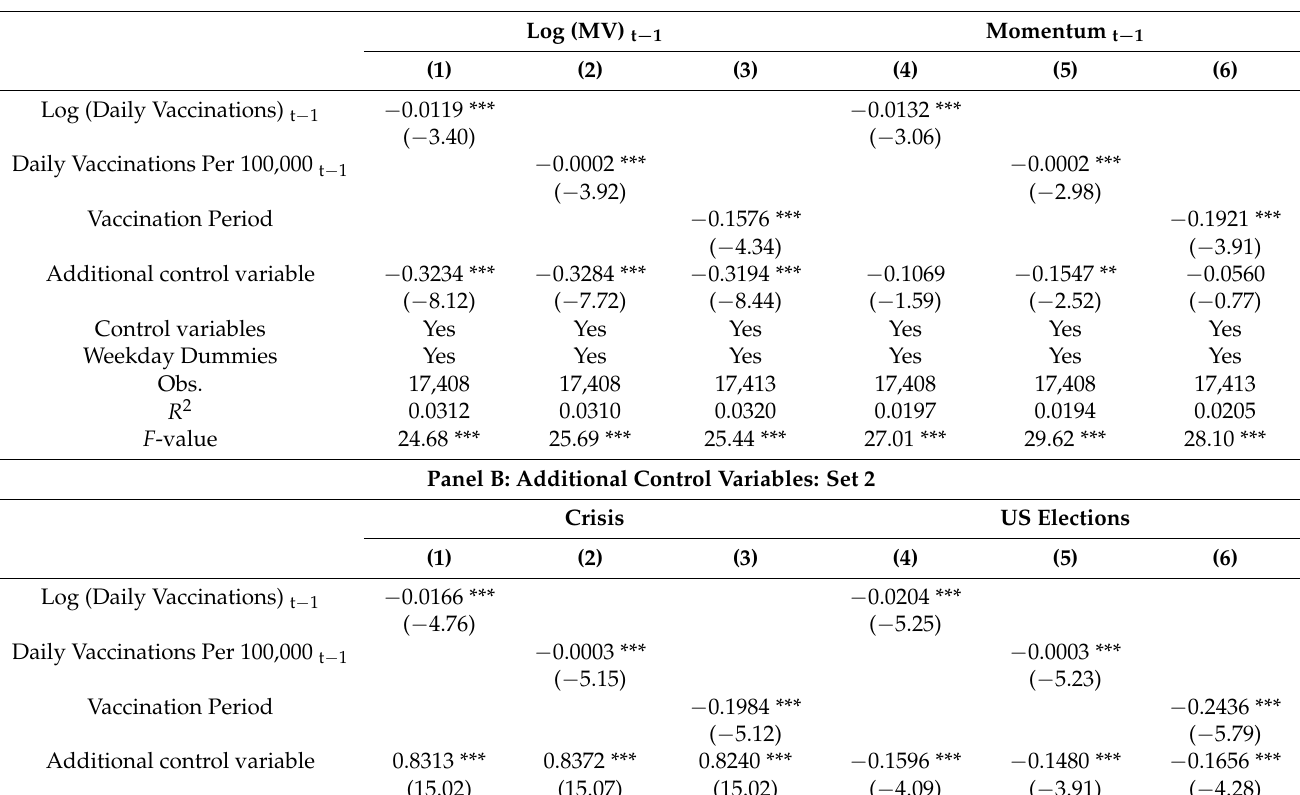
Table 6. Robustness tests: additional control variables and alternative study periods. Panel A: Additional Control Variables: Set